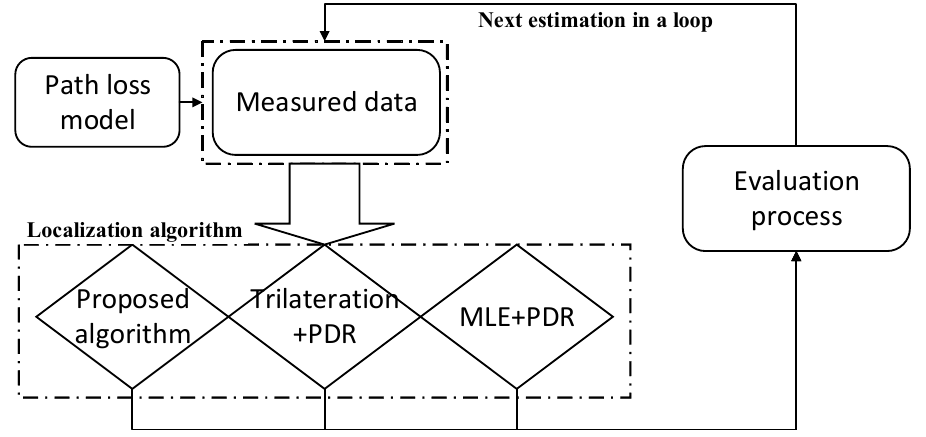
Figure 9. The procedure for evaluation of the proposed PPSA.